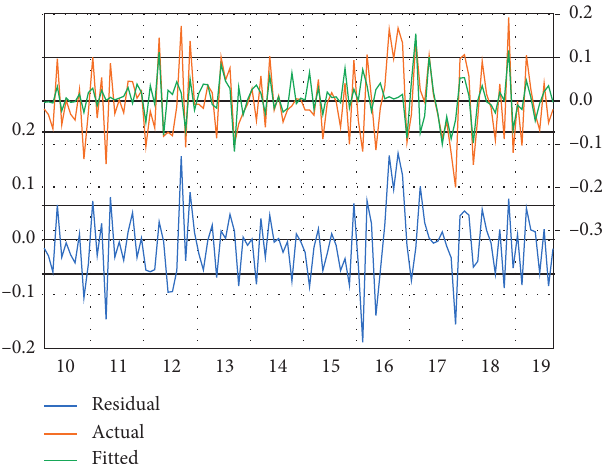
Figure 5: Fitting of the SARIMA ( 4 , 1 , 2 )( 1 , 1 , 1 ) 12